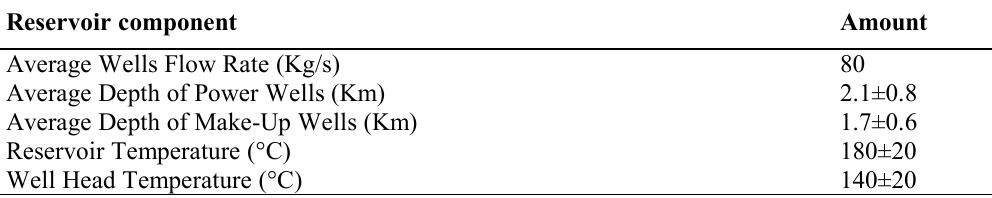
Table 13 . Mahallat-Isfahan geothermal reservoir